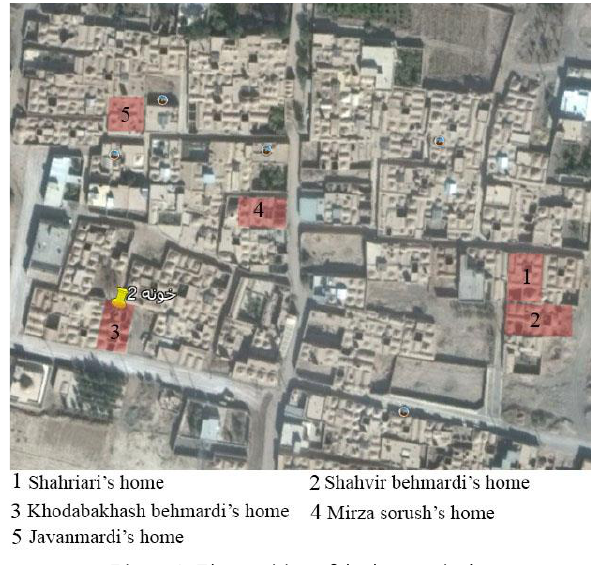
Figure 2. The position of the houses in the aerial photograph, year of